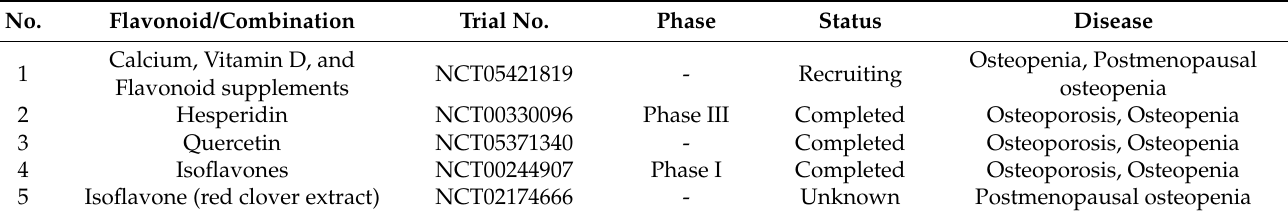
Table 5. Patents of flavonoids for treating bone loss.